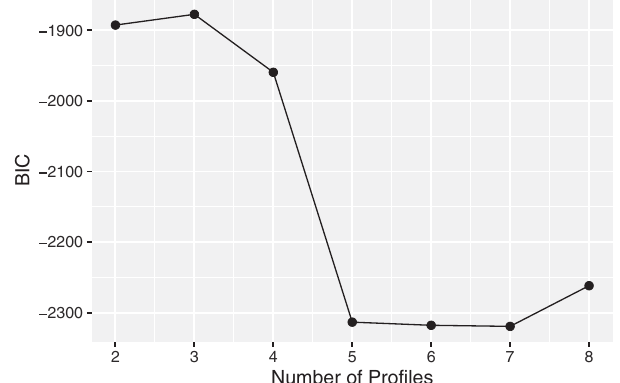
FIG. 2. BIC vs number of profiles. We see a slight increase in BIC from two (BIC -1892) to three (BIC -1877) profiles, and then a sharp drop to 4 (BIC -1959) until five (-2314) profiles. Five, six (BIC -2318), and seven (BIC -2320) profiles have nearly equal BIC values, before increasing again with eight (BIC